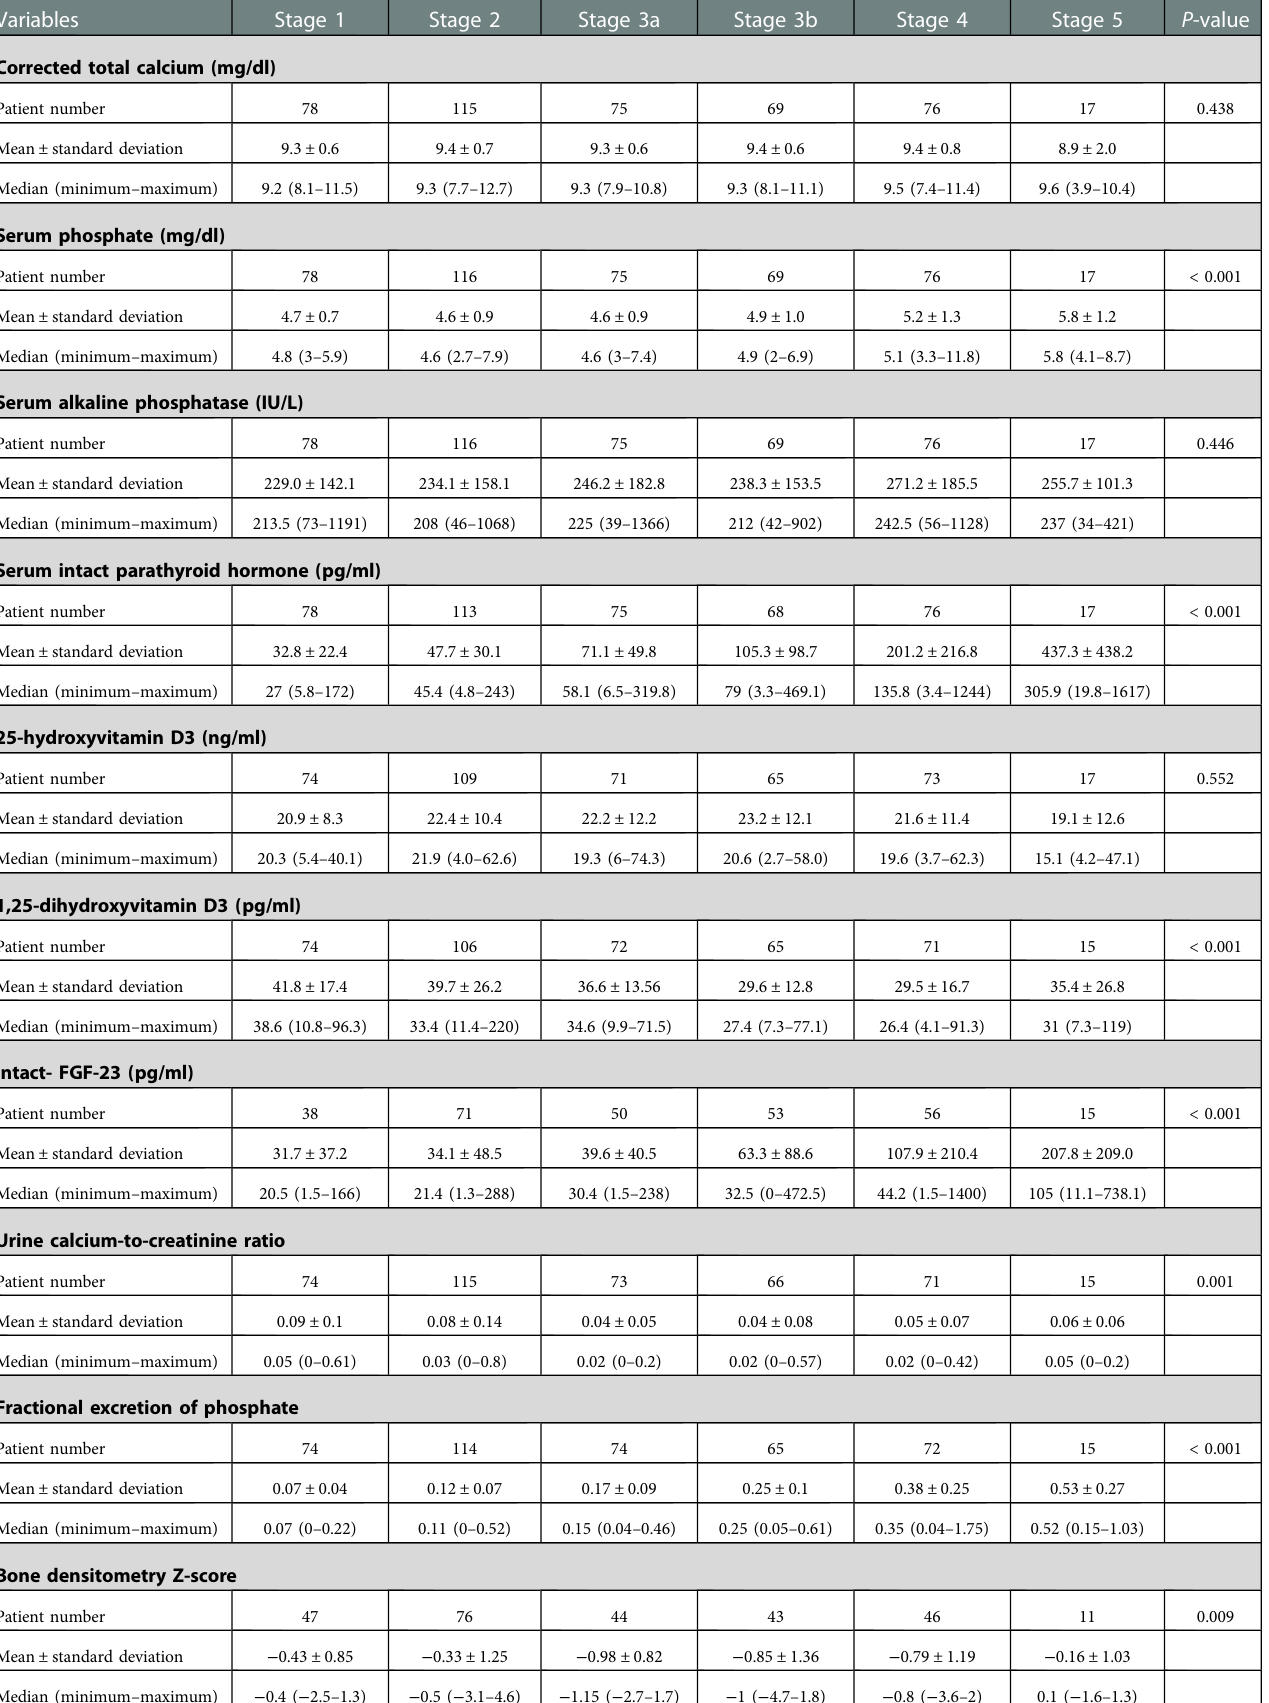
TABLE 1 Disordered mineral metabolism in the KNOW-Ped CKD cohort according to CKD